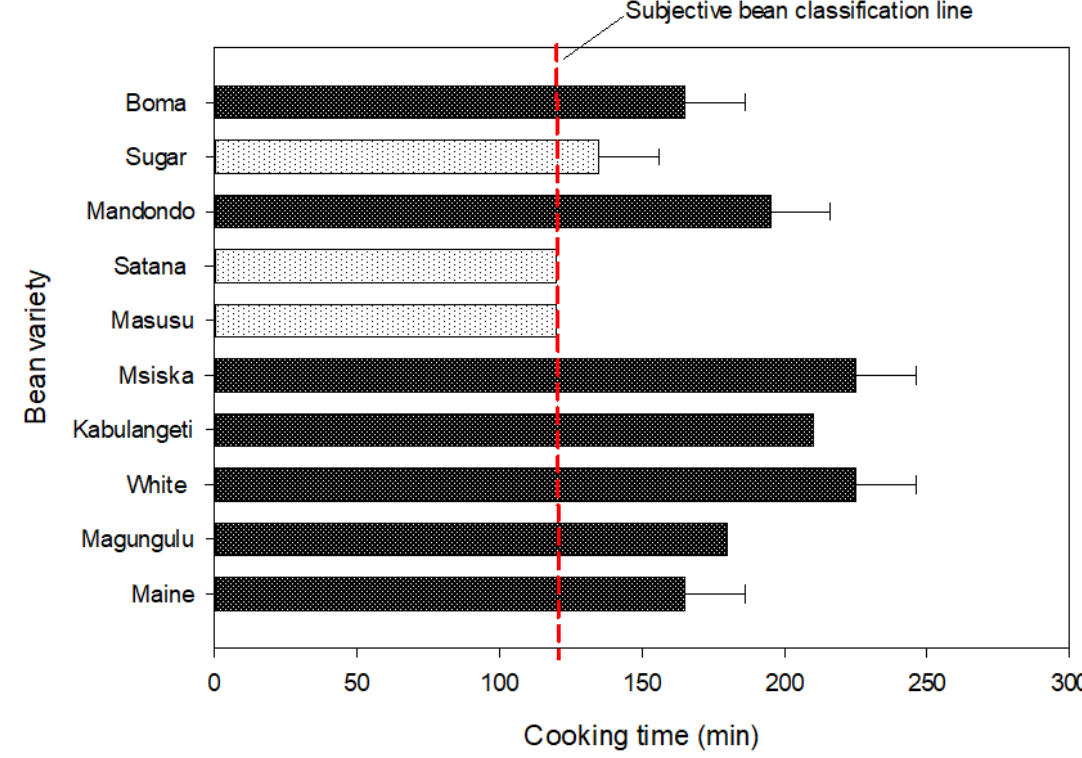
Figure 1. Subjective hardness test of the bean cultivars. (The red line represents the subjective bean classification line. Bean cultivars below the line are easy-to-cook (ETC), while those above the line are hard-to-cook